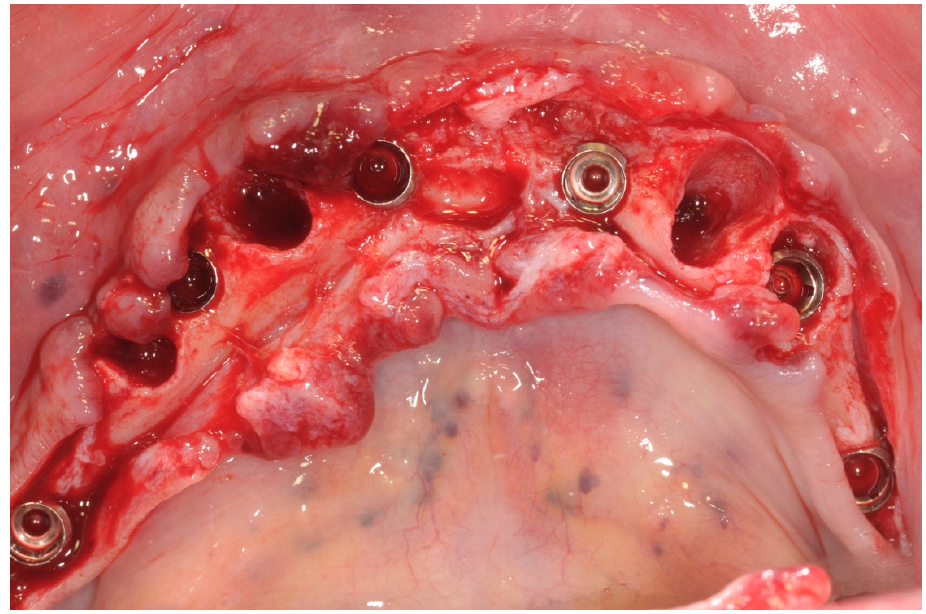
Figure 3. Implants were inserted, and flat abutment connected.